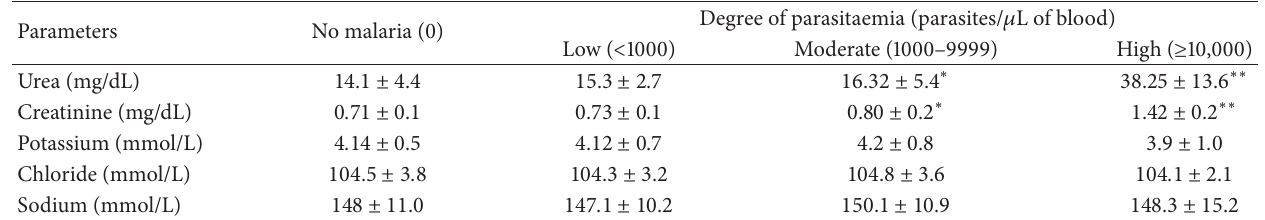
Table 2: Biochemical parameters in relation to degree of parasitaemia and no